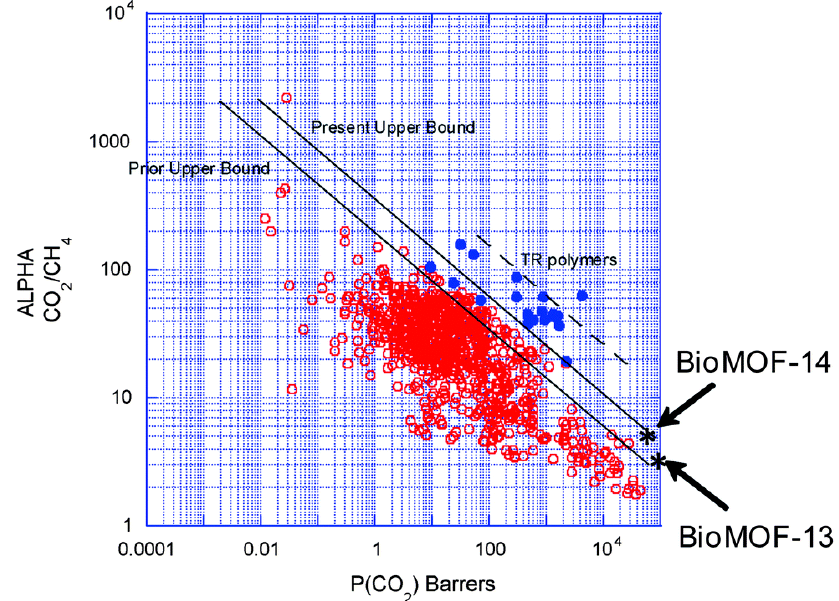
Figure 54. Revisited Robeson plot for CO 2 /CH 4 mixtures. The separation performance for I and II membranes is included in the plot (adapted with permission from ref. [150]).